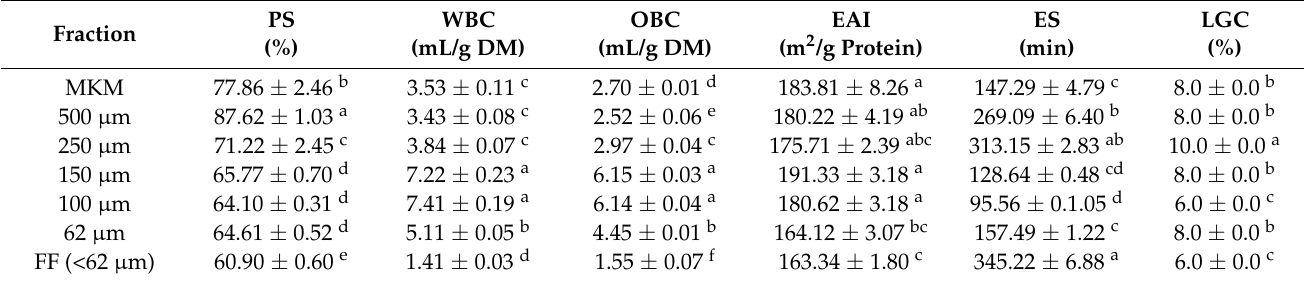
Table 4. Functional properties of the fractions after the representative sieve fractionation of macauba kernel